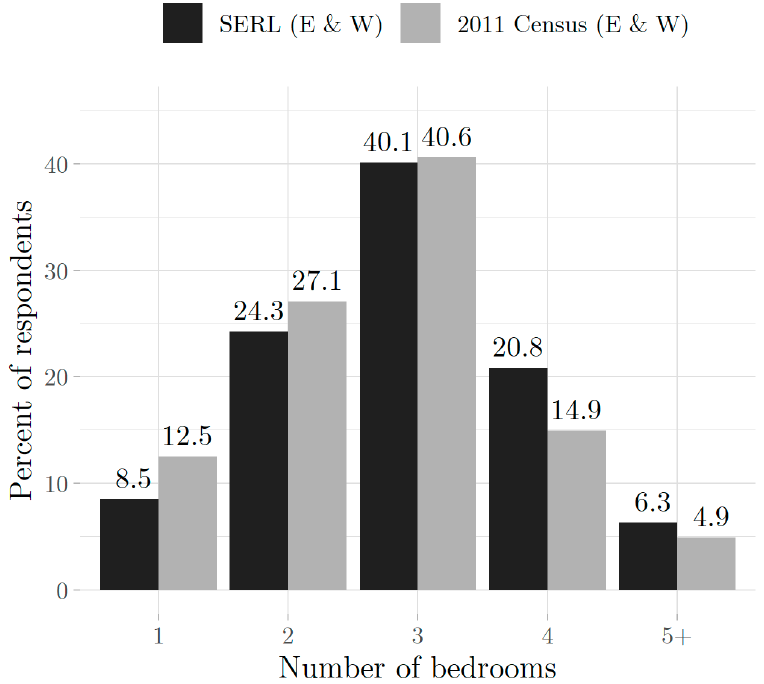
Figure 16. The number of bedrooms in SERL Observatory dwellings in England and Wales (E & W) compared to those reported in the 2011 Census (England and Wales only as bedroom data not avail- able for